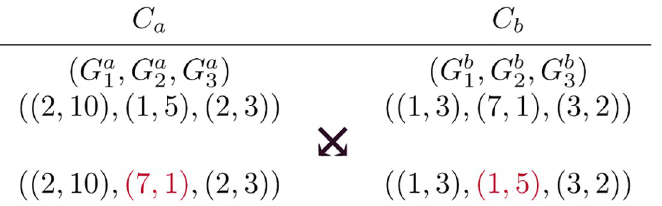
Fig 4. Crossover example where the genes related to Flow 2 are swapped to generate a new routing